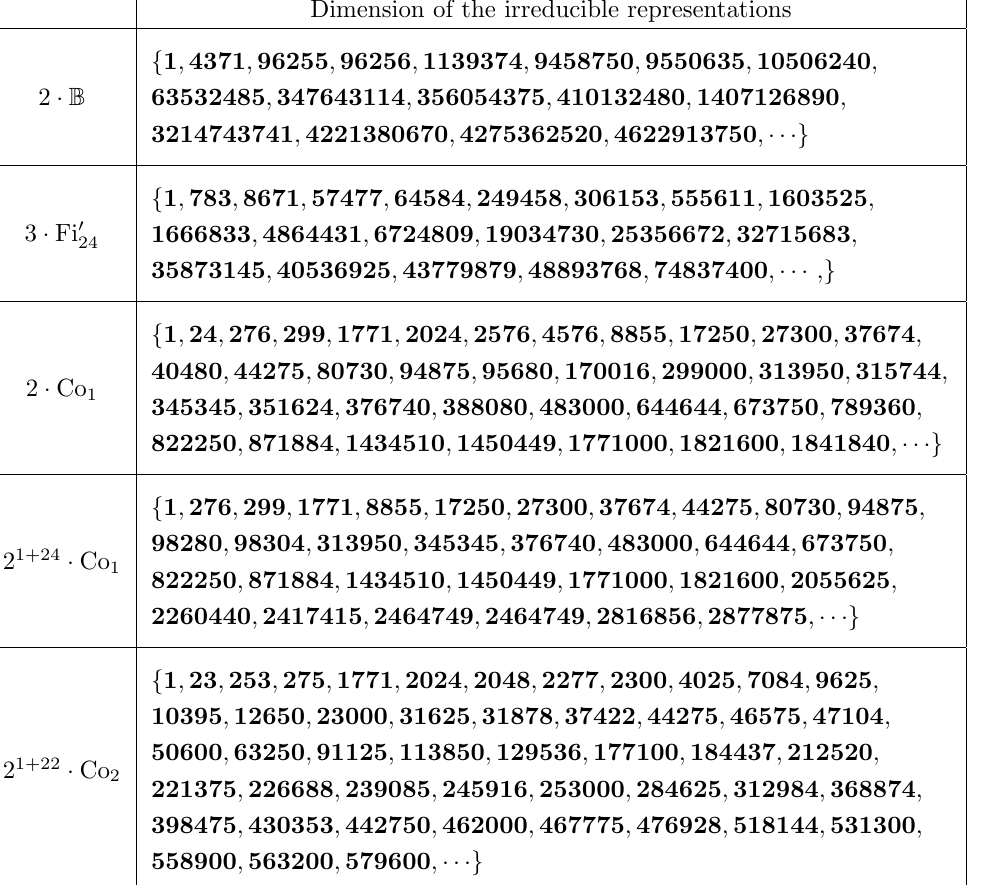
Table 1 . Dimension of the irreducible representation in various sporadic groups. The list of the representation read from GAP package